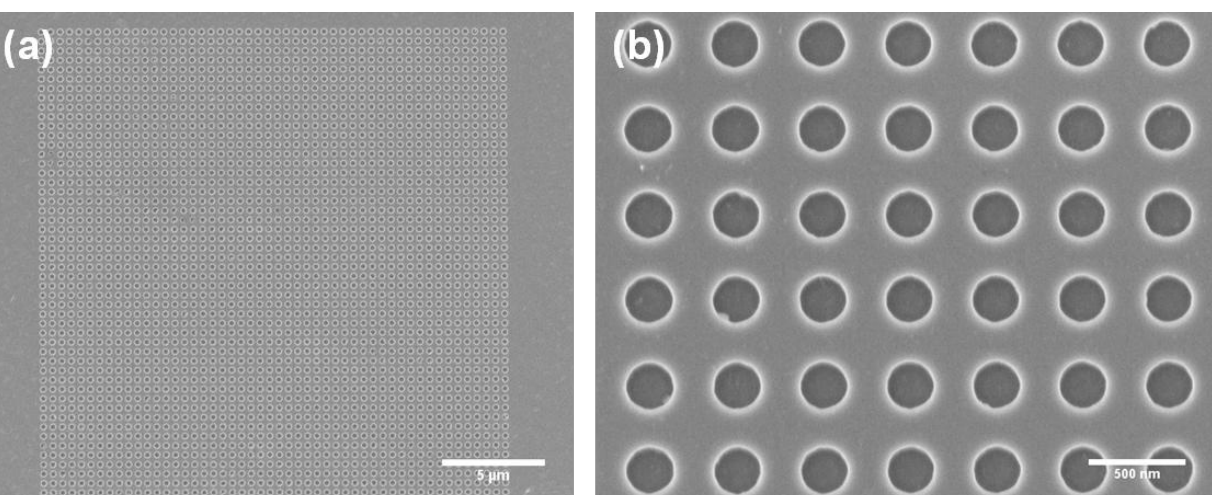
Figure 2. ( a ) and ( b ) SEM images of a master mold with nanohole square arrays (hole diameter 250 nm, periodicity 450 nm, depth 130